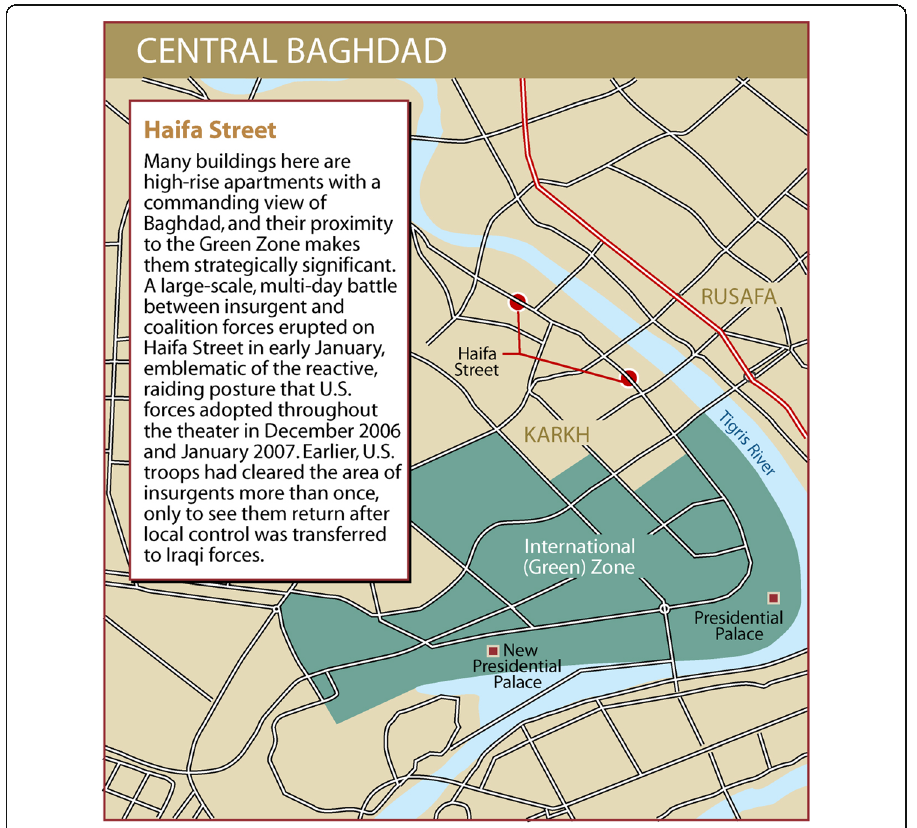
Fig. 2 Map of Karkh district (Institute for the Study of War